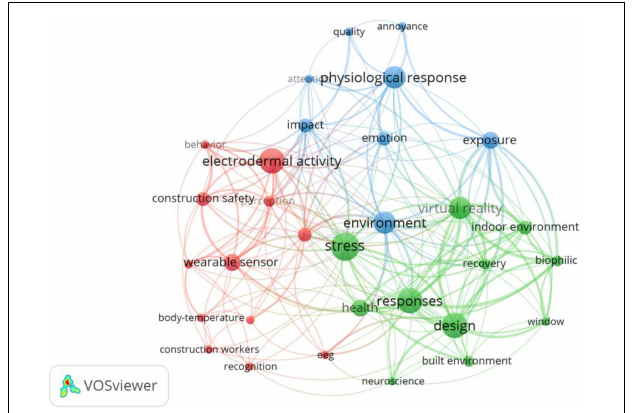
FIGURE 8 | Keywords co-occurrence network of EDA in building